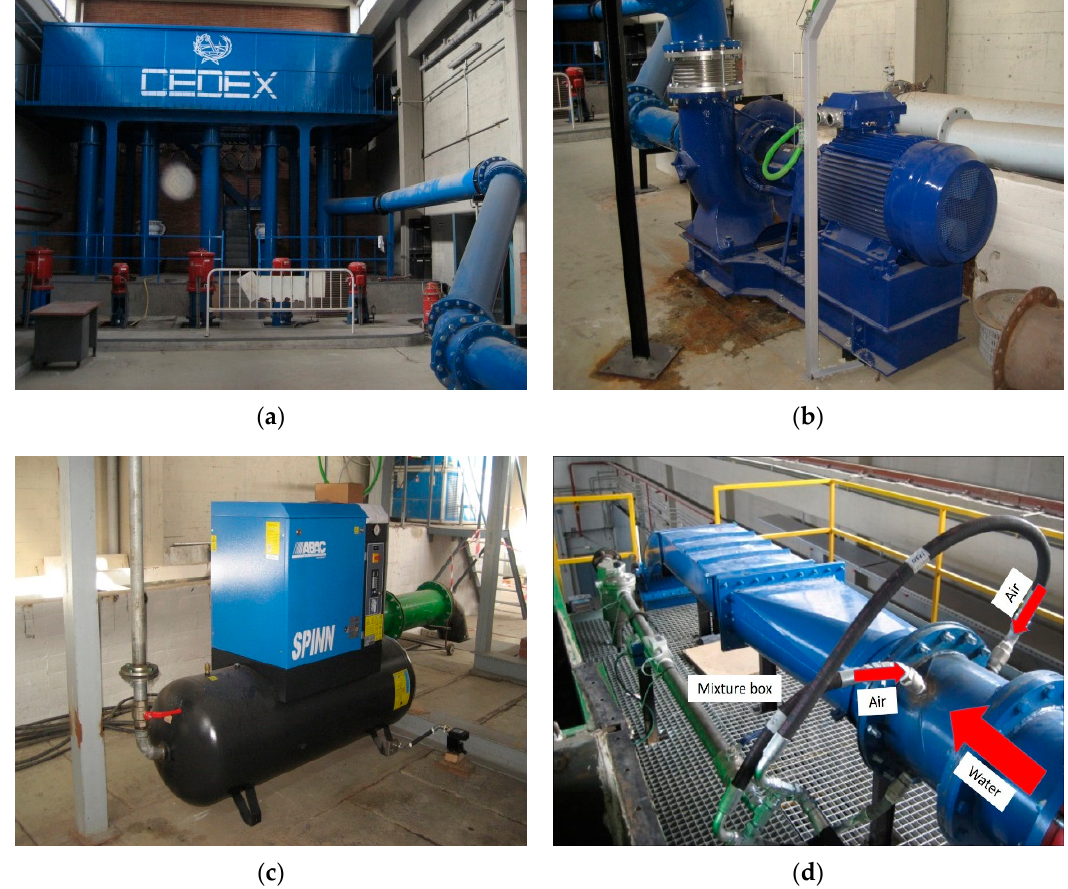
Figure 2. Water and air supply equipment: ( a ) Water gauger; ( b ) Water pump; ( c ) Air compressor; ( d ) Air-water mixture box.